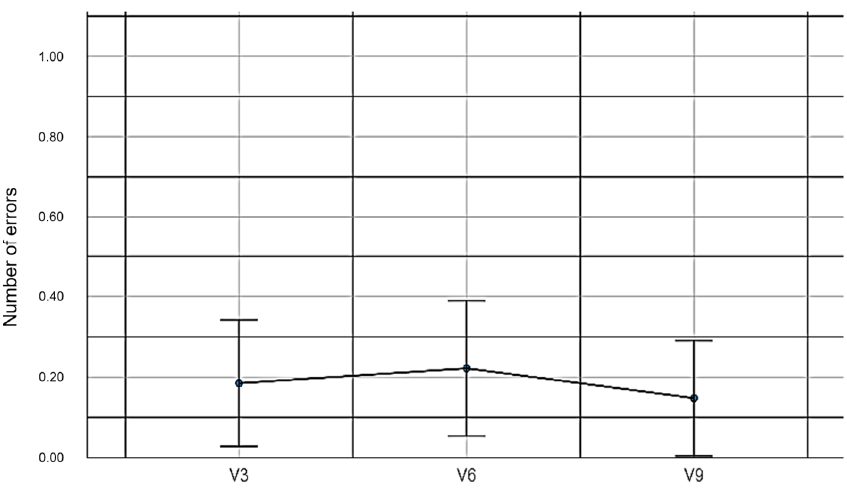
Figure 10. Numbers of errors made in the pairing cards experiment. When comparing the execution times in the maze experiment with the use of the mouse and the EMKEY emulator with head movements, statistically significant differences were found ( t (52,1) = − 18.45, p ≤ 0.001, d = 9.60). These data do not support the proposed hypothesis. Table 7 shows the values obtained in this comparison. Table 7. Maze experiment runtimes.